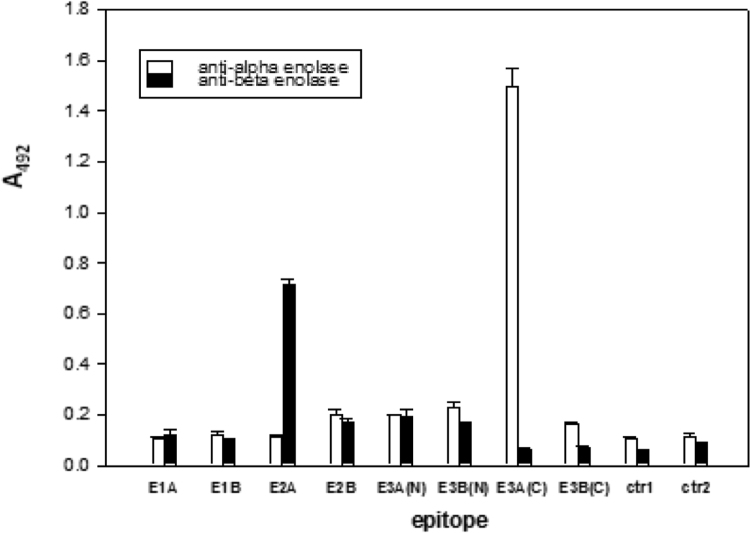
Interaction of polyclonal anti-enolase antibodies with pin-attached peptides representing α- and β-enolase epitopes. Dilution of antibody against β-enolase and α-enolase was 1:100 and 1:1000, respectively. Data are representative of three experiments (n = 3). E1A –α-enolase epitope 1 [D51NDKTRYMGK60 -GG-pin], E1B –β-enolase epitope 1 [D52GDKGRYLG K61 -GG-pin], E2A –α-enolase epitope 2 [N194VIKEKYGKDATN206 -GG-pin], E2B –β-enolase epitope 2 [G195VIKAKYGKDATN207 -GG-pin], E3A(N) –α-enolase epitope 3 (N-terminal fragment) [R253SGKYDLDFK262 -GG-pin], E3B(N) –β-enolase epitope 3 (N-terminal fragment) [R254NGKYDLDFK263 -GG-pin], E3A(C) –α-enolase epitope 3 (C-terminal fragment) [S263PDDPSRYISPDQ275 -GG-pin], E3B(C) –β-enolase epitope 3 (C-terminal fragment) [S264PDDPARHITGEK275 -GG-pin], ctr1 – non-epitope sequence in both α- and β-enolases [K343VNQIGSVTES353 -GG-pin], ctr2 – computer generated random sequence [TQLRAVNHASDF-GG-pin].